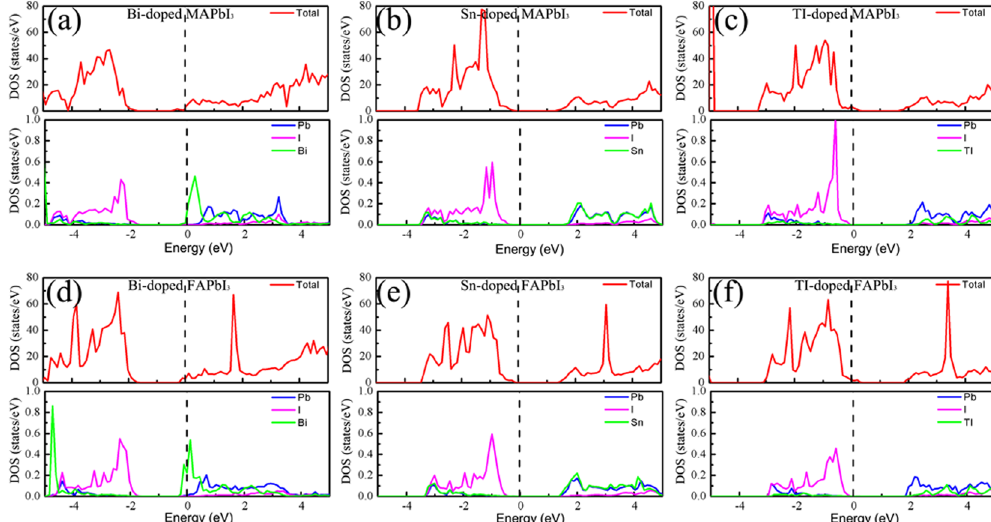
Figure 3. The total DOS and PDOS of Pb, I, and defect in the ( a ) Bi-doped MAPbI 3 , ( b ) Sn-doped MAPbI 3 , ( c ) TI-doped MAPbI 3 , ( d ) Bi-doped FAPbI 3 , ( e ) Sn-doped FAPbI 3 , and ( f ) TI-doped FAPbI 3 . In order to facilitate comparison with PDOS of defect, the PDOS of Pb and I is the average PDOS per atom. The total DOS and PDOS are shown on the upper and low panel in the subfigure. The red, blue, violet, and green lines represent the total DOS, PDOS of Pb, I, and doped cation, respectively.